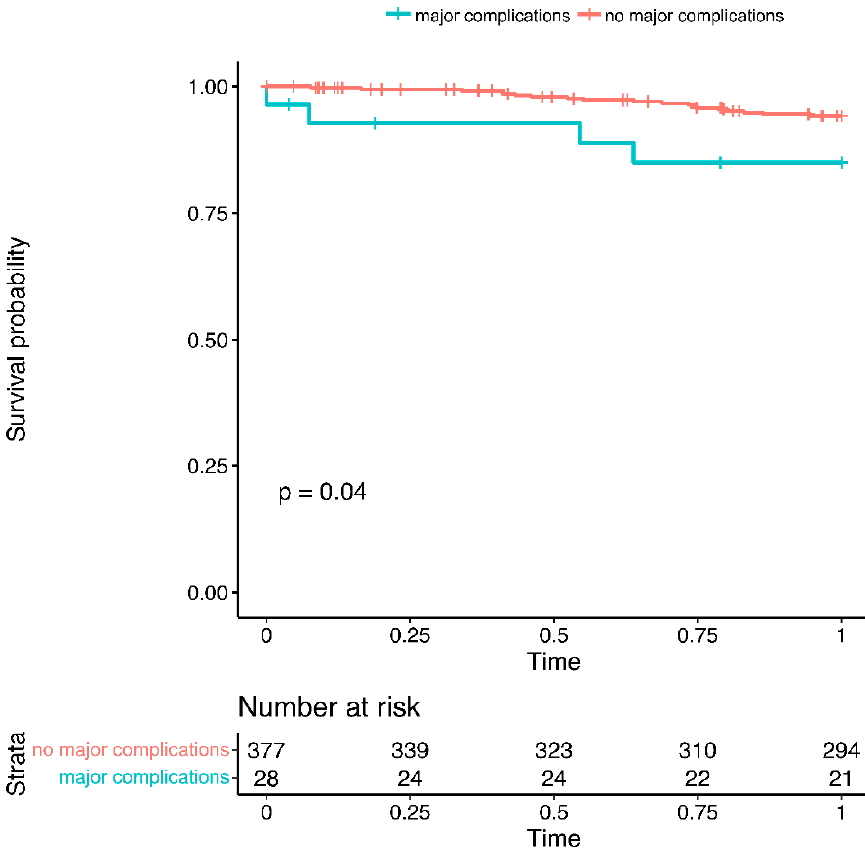
Figure 2. One-year mortality in patients with vs. without major complications.